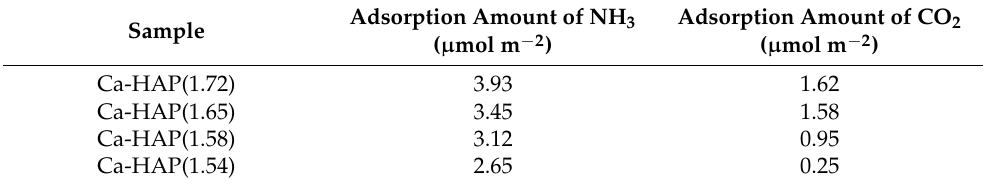
Table 3. Adsorption amounts of NH 3 and CO 2 on Ca-HAP catalysts with various Ca/P molar ratios.